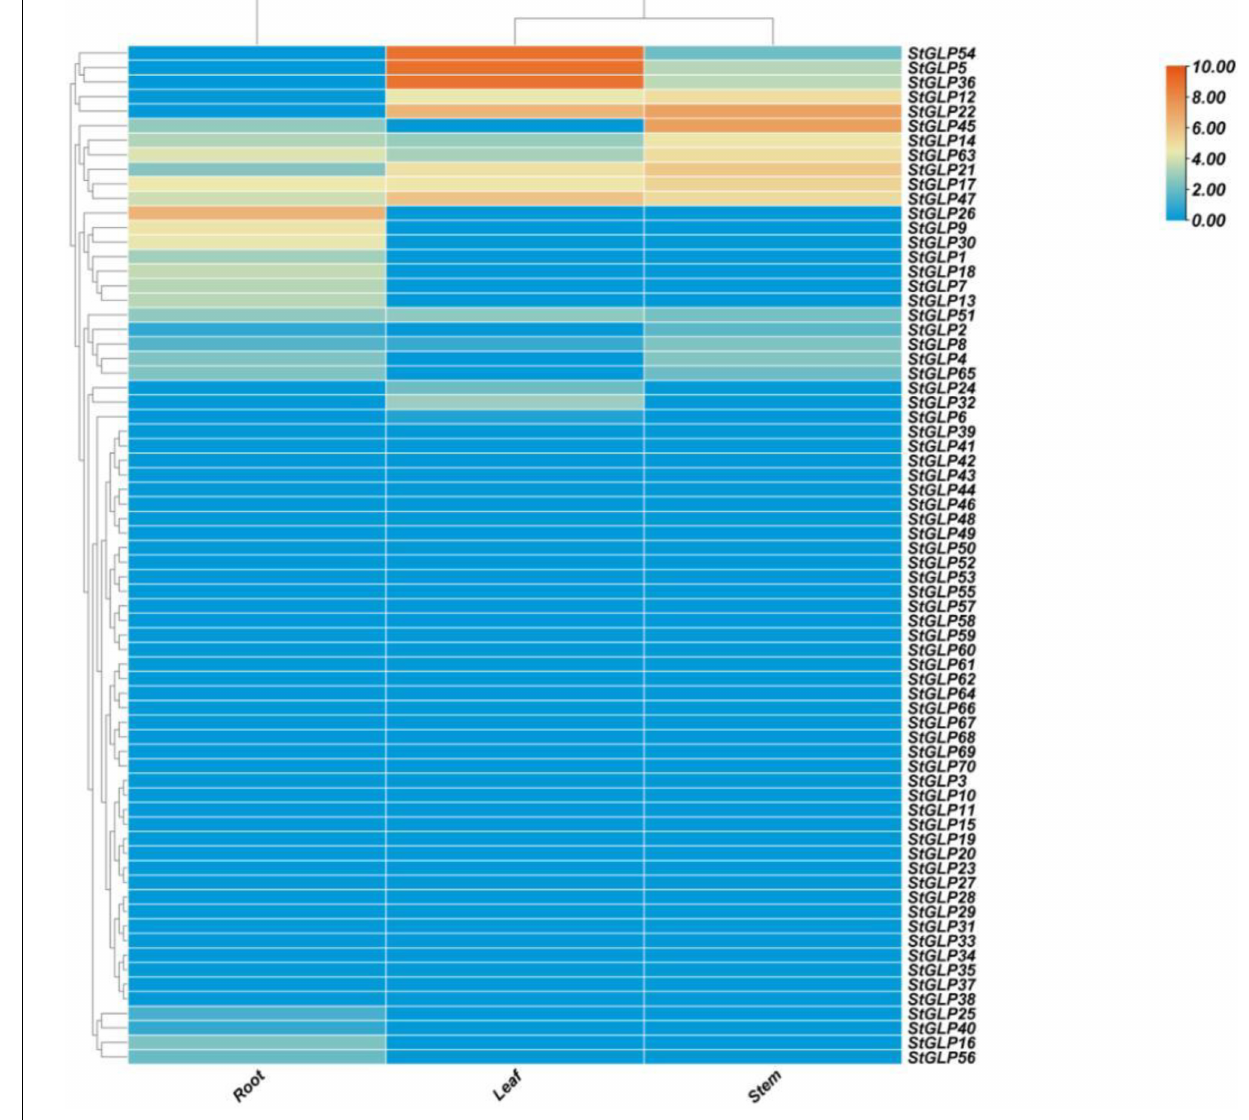
FIGURE 8 | Expression profiling of StGLP genes in leaves, roots, and stems. The orange and blue colors display high- to low-expression levels. The expression heat map was created by taking log10 normalized values of fragments per kilobase million